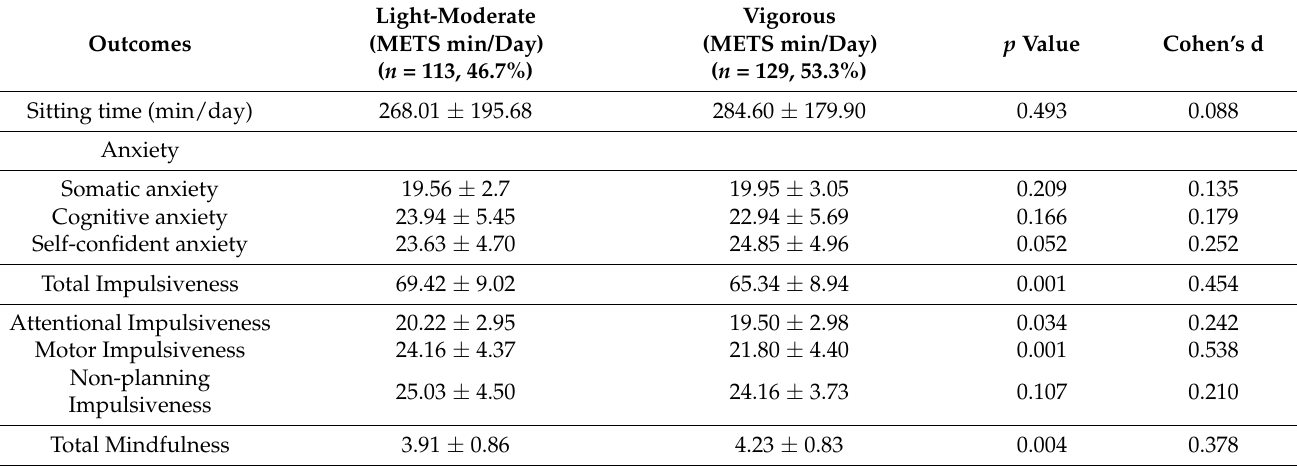
Table 3. Comparisons between PA levels with anxiety, mindfulness, and